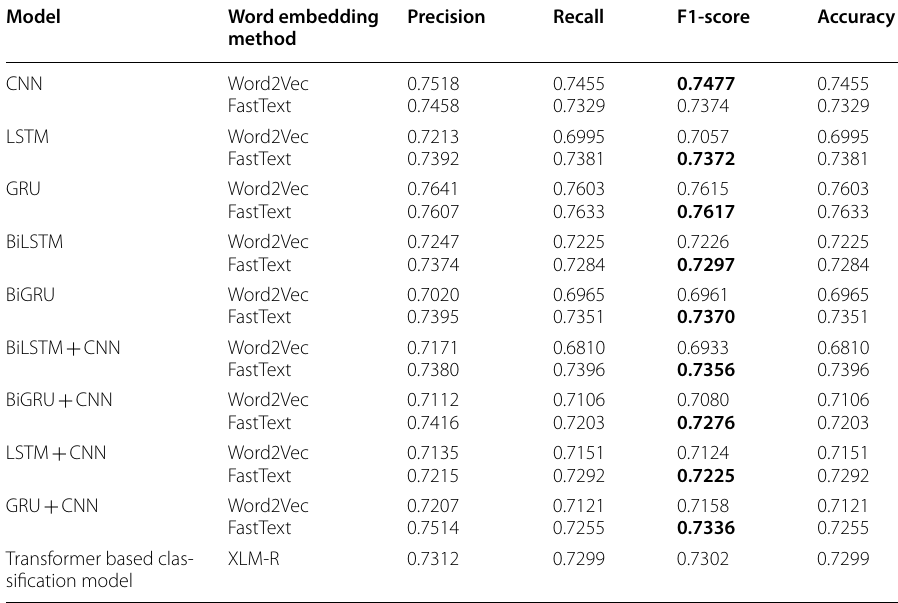
The bold numbers represent the highest F1‑score obtained for each